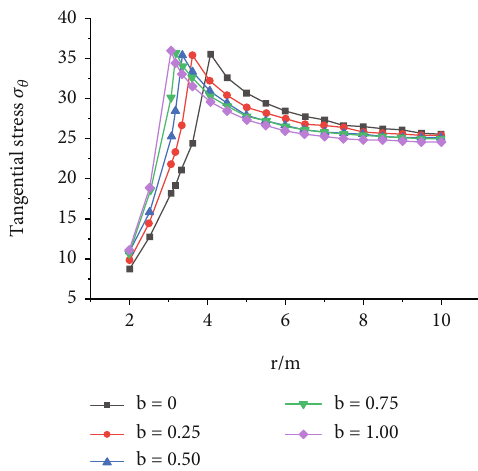
Figure 9: Tangential stress distribution of surrounding rock corresponding to di ff erent b values ( P 0 = 2MPa ).